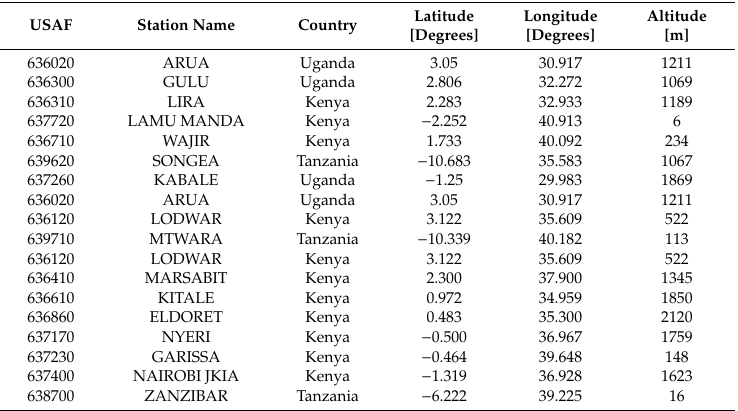
Table A1. Meteorological stations used. United State Air Force number (USAF), station name, country, latitude, longitude and altitude.